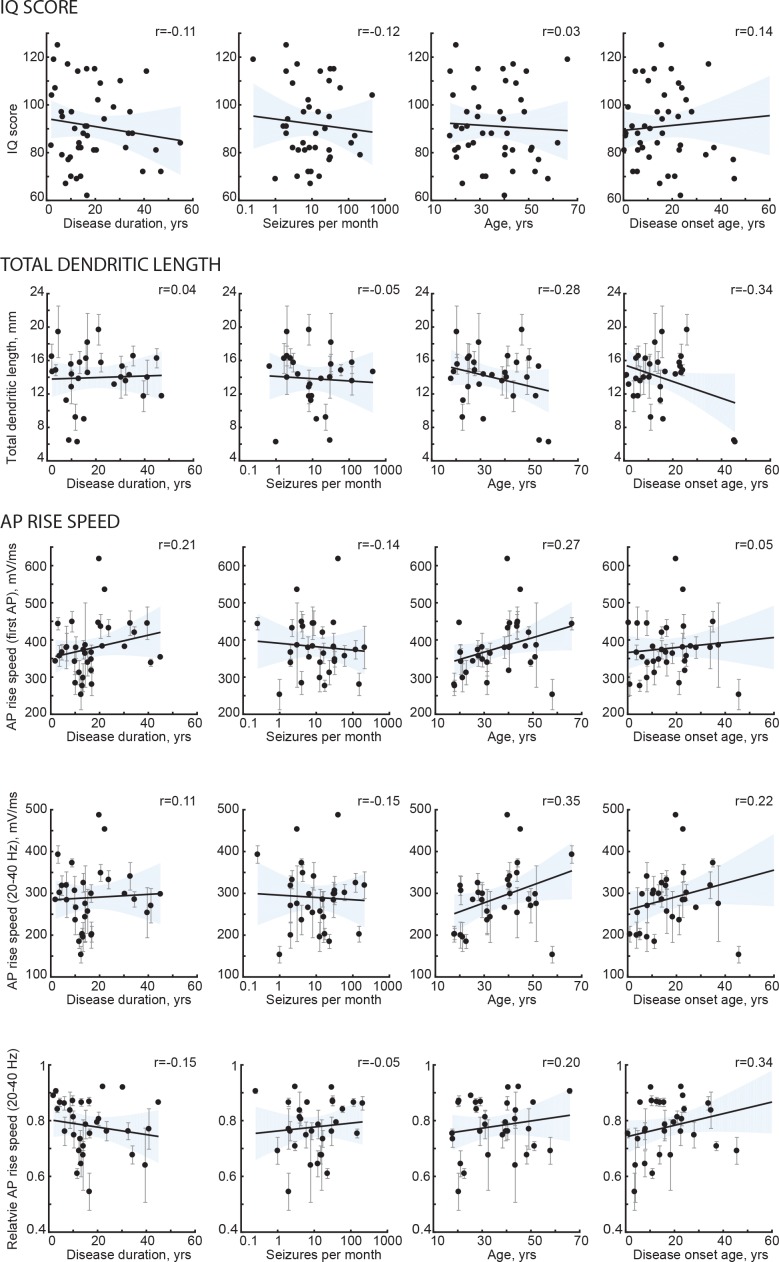
Subject disease history and age do not correlate with IQ and neuronal morphology.Black lines are the regression lines, shading represents 95% confidence intervals, data are mean per subject ±standard deviation.